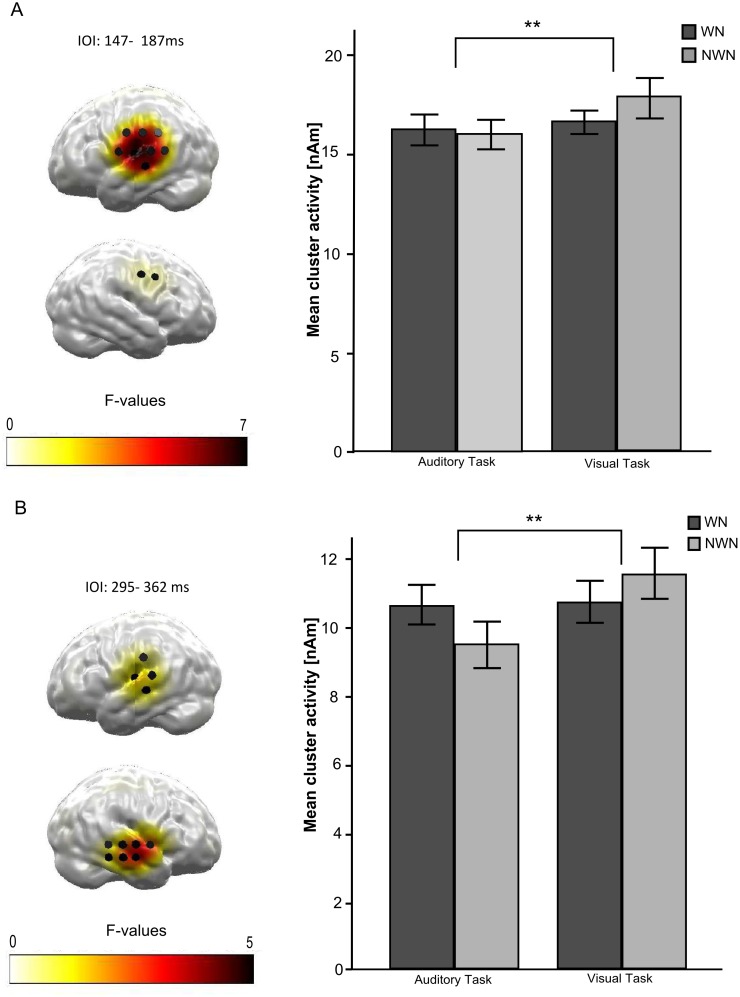
Results for the interaction effect of noise type x attentional focus in the bilateral temporal region of interest (ROI) for the two different intervals of interests (IOI).Only regions surviving cluster-based permutation are colorized. F-values corresponding to a corrected p < .01. Black cylinders indicate the locations of dipoles selected as the temporal ROI. **p < .01. (A) Left: Statistical parametric map of F-values for the interaction effect noise type x attentional focus averaged between 147 and 187 ms. Right: Corresponding mean ROI activity evoked by the TT after WN (black) and after NWN (grey) presented separately for the auditory and visual task. Bars denote within-subject 95%-confidence intervals (B) Left: Statistical Parametric Map of F-values for the interaction effect noise type x attentional focus averaged between 295 ms and 362 ms. Right: Corresponding mean ROI activity evoked by the TT after WN (black) and after NWN (grey) presented separately for the auditory and visual task. Bars denote within-subject 95%-confidence intervals.